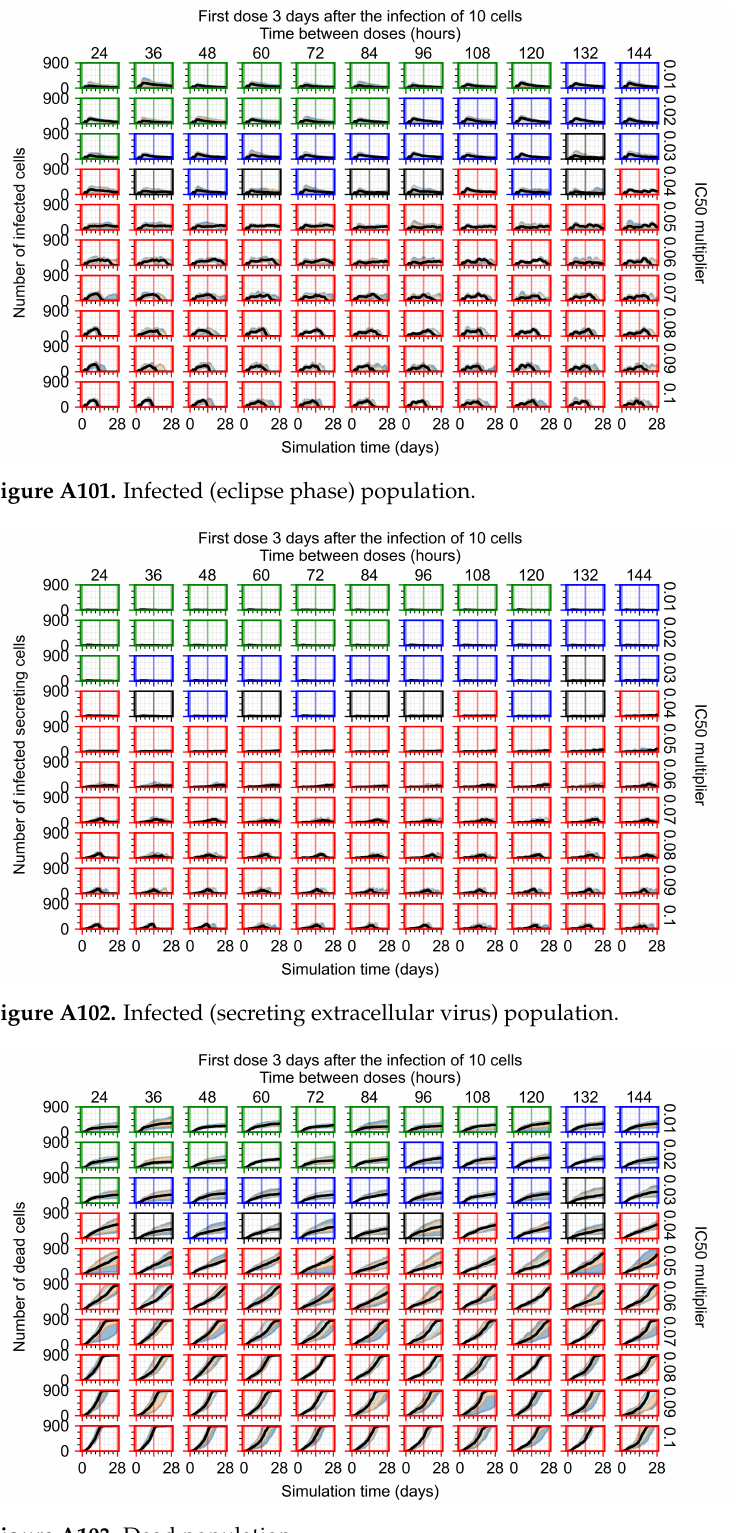
Figure A103. Dead